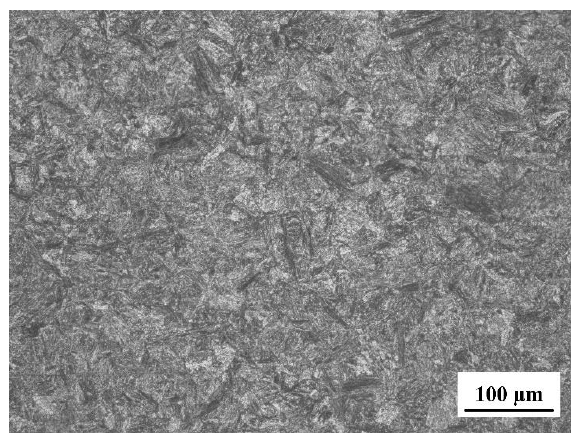
Figure 2. Microstructure of quenched and tempered 40Cr steel.